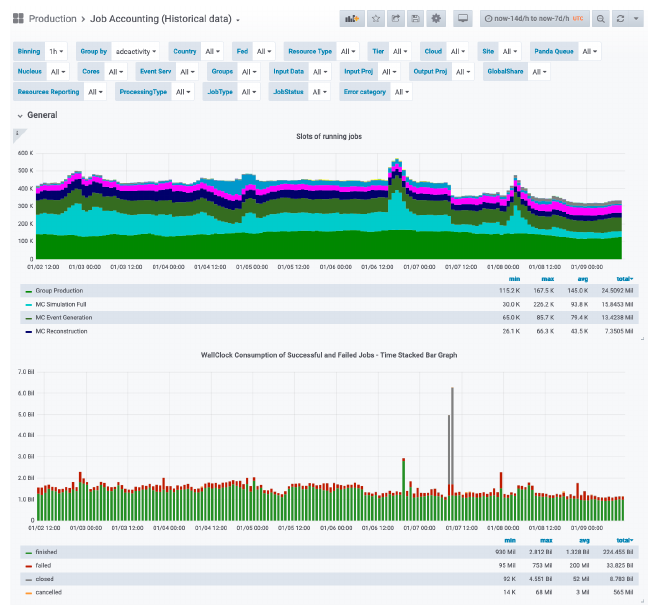
Figure 4. Overview of the Job Accounting Dashboard